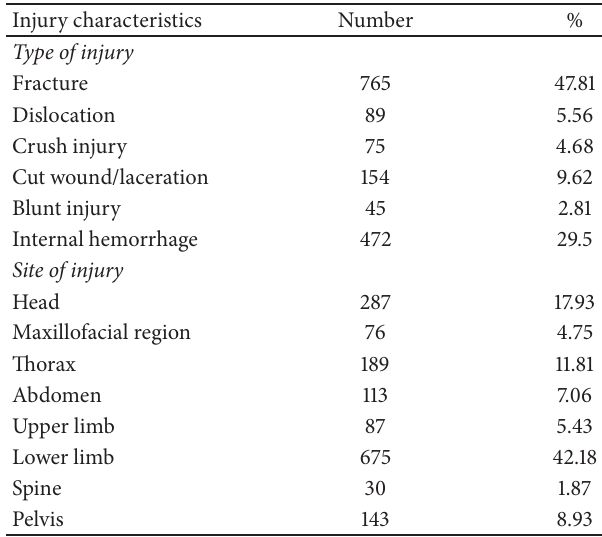
Table 2: Distribution of the victims of RTAs according to type and site of injured persons ( 𝑁 = 1600